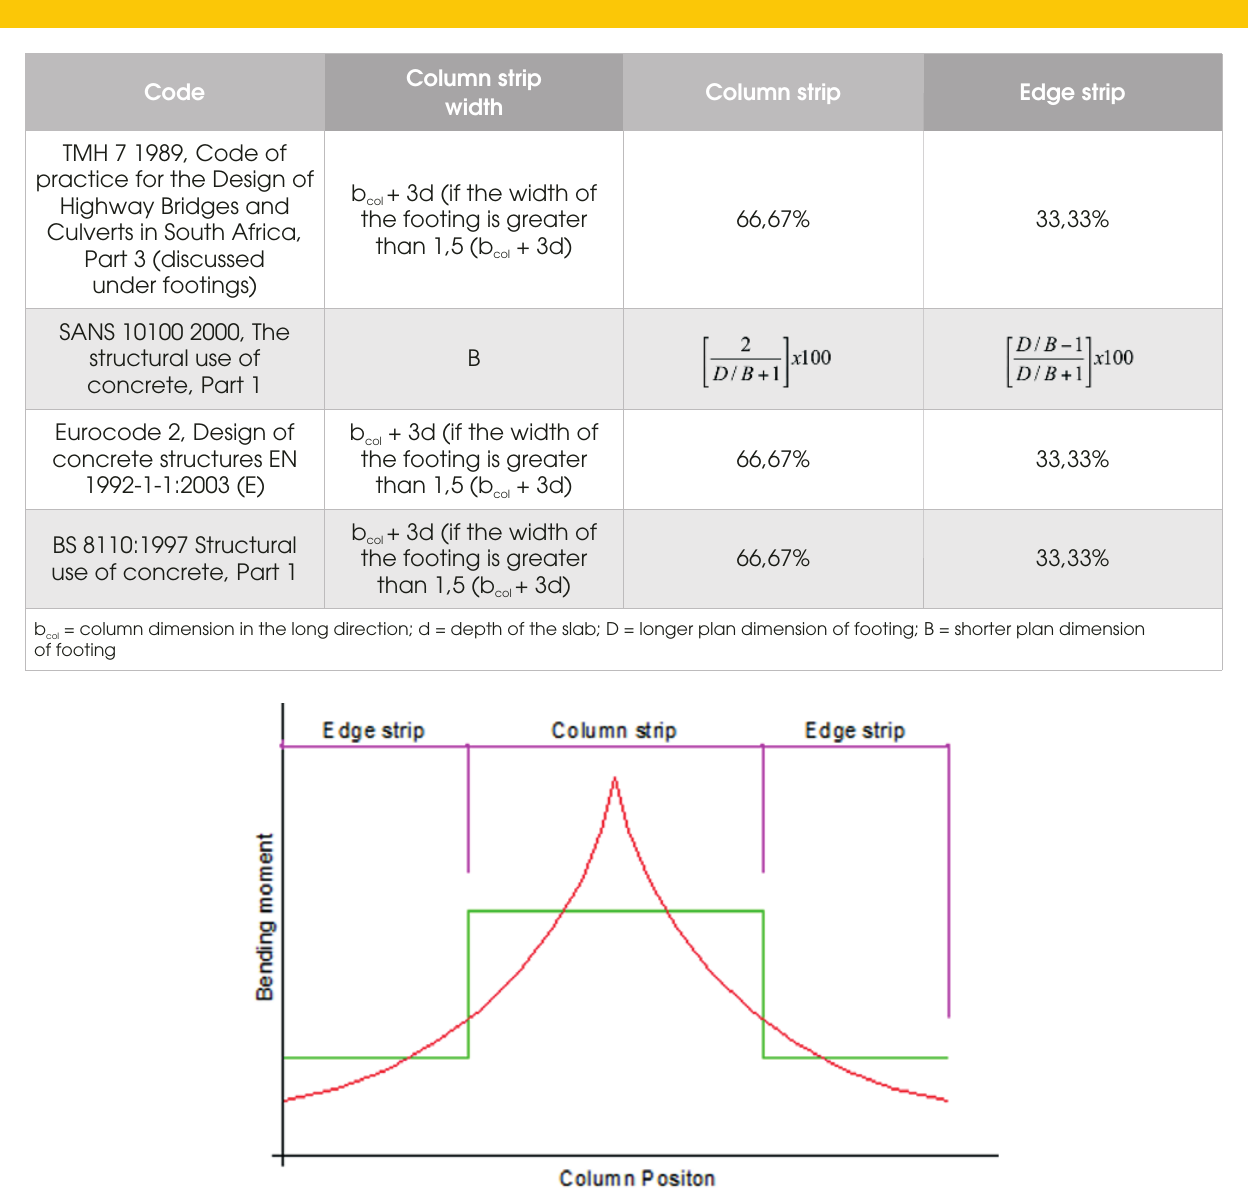
Column strip width